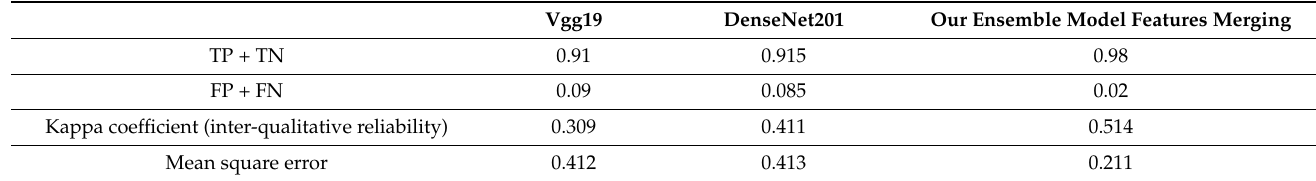
Table 6. Statistics metrics for the compared models for the BIG-D15 dataset. Vgg19